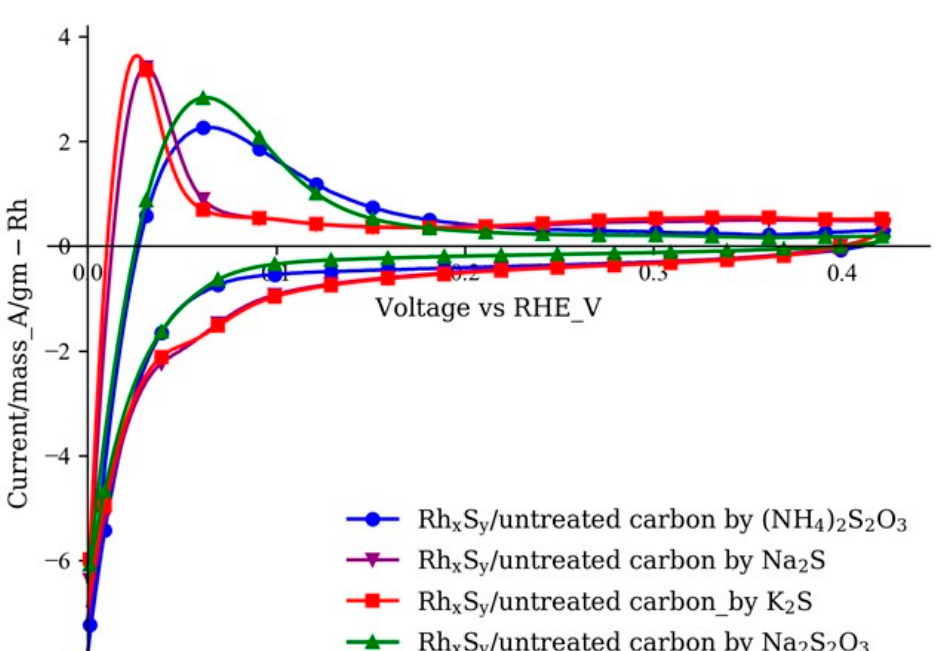
Figure 1. Cyclic voltammograms of Rh x S y synthesized by the sulfur sources with different cations and anions (electrolyte: 1 M N 2 -saturated H 2 SO 4 solution; working electrode: catalyst-coated GDE; counter electrode: Pt foil; reference electrode: saturated calomel electrode (SCE); scan rate: 10 mV/s).